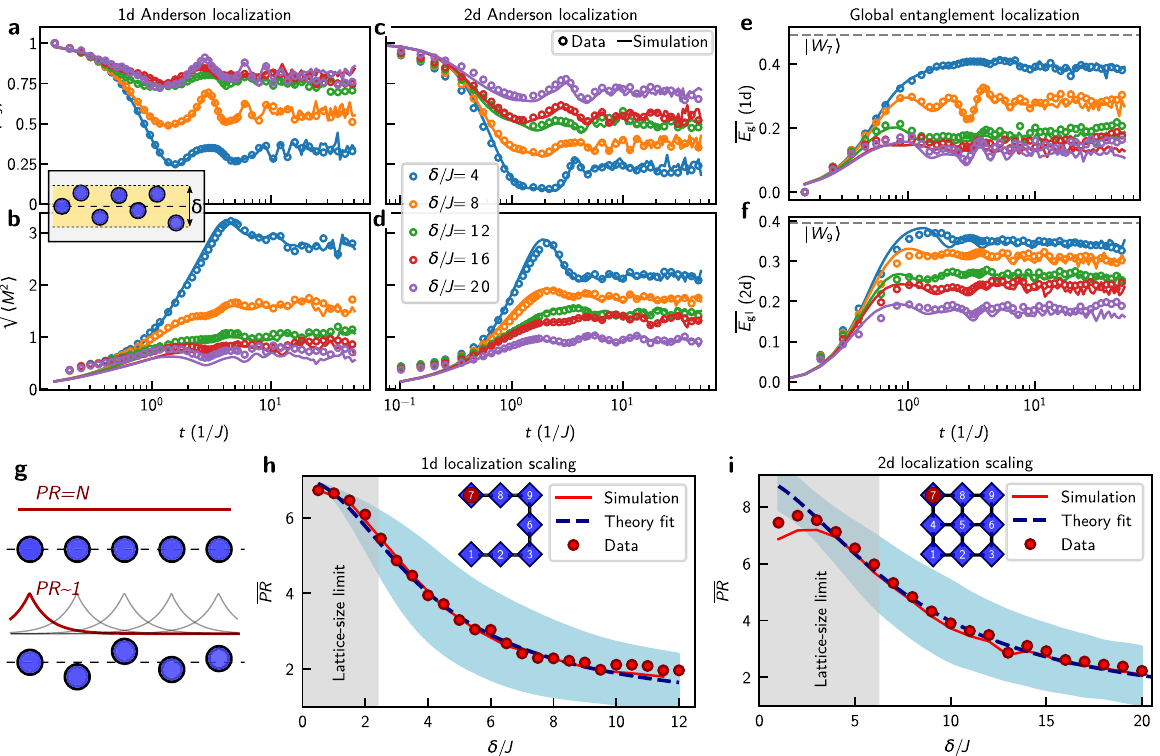
Fig. 3 Anderson localization. Population at the propagation source ( a ) and particle root mean-squared distance from the source ( b ) for different 1d lattice disorders. Each point is averaged over 50 disorder realizations. Population at the propagation source ( c ) and particle mean- squared distance from the source ( d ) for different 2d lattice disorders. Each point is averaged over 50 disorder realizations. The global entanglement among the sites in the 1d lattice ( e ) and 2d lattice ( f ) measured at different disorder strengths averaged over 50 realizations. g The wavefunction for a completely delocalized state takes the value of PR = N , whereas PR = 1 for a wavefunction fully localized to a single site. h 1d Anderson localization participation ratio PR scaling with disorder strength, obtained using 60 random lattice realizations for each value of disorder strength δ . The blue shaded region indicates the simulated statistical uncertainty interval (±1 standard deviation) as a result of lattice randomization. i 2d Anderson localization PR scaling with disorder strength, obtained using 180 random lattice realization for each value of δ disorder as propagation occurs along multiple paths between two sites. As a result of localization caused by disorder, the emergence of multipartite entanglement in the tight-binding lattice is inhibited: in Fig. 3e, f, we report a decrease in the steady state value for the average global entanglement of the system, E gl , with